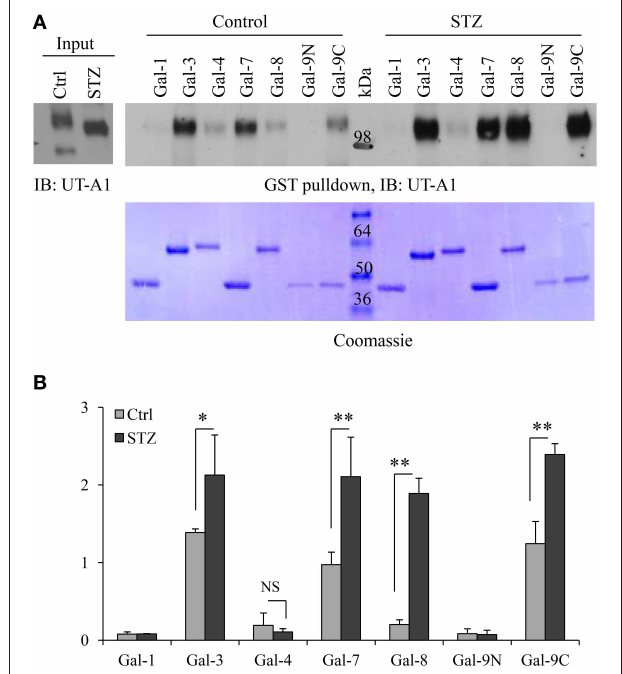
FIGURE 2 | GST-galectin pulldown assays. (A) Equal amount of cell membrane fractions from rat IM tip were incubated with freshly prepared GST-galectin proteins for 1h at 4 ◦ C. After washing with buffer A containing 14mM β -mercaptoethanol and buffer containing 0.1M sucrose, the galectin specific binding proteins were eluted by 0.1M lactose (specific-binding) and subsequently analyzed by Western blot with UT-A1 antibody (Top). The same membrane was stained by Coomassie brilliant blue to verify GST fusion galectin proteins (Bottom). (B) Densitometry analysis of UT-A1 protein bands from three separate experiments ( n = 3 ). Each GST-galectin precipitated UT-A1 was normalized with UT-A1 from input (means ± SD, * P < 0.05 , ** P < 0.01 , NS, no